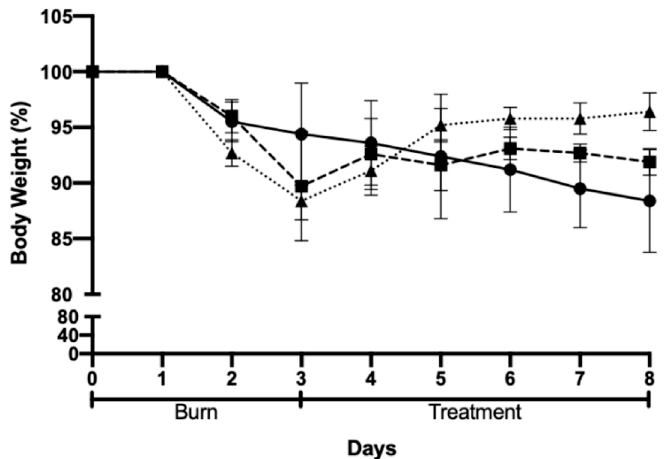
Figure 6. Body weight variation after chemically induced skin burn and treatment: Pluronic ® F127 hydrogel (negative control, circles); Positive control (commercial formulation of silver sulfadiazine squares); and test group, AgNPs incorporated in Pluronic ® F127 hydrogel (triangles).